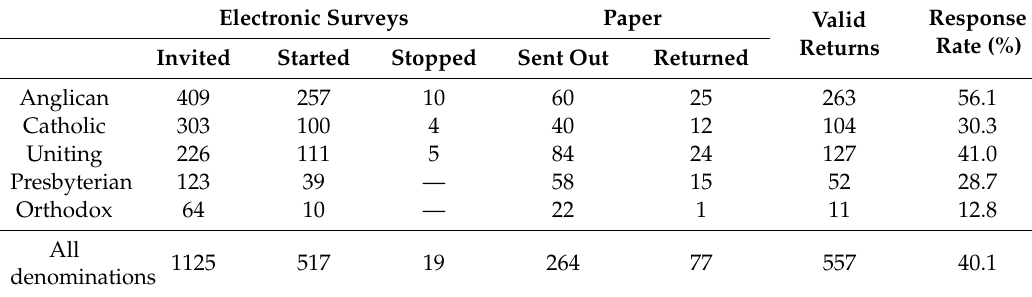
Table 1. Details of surveys sent out and